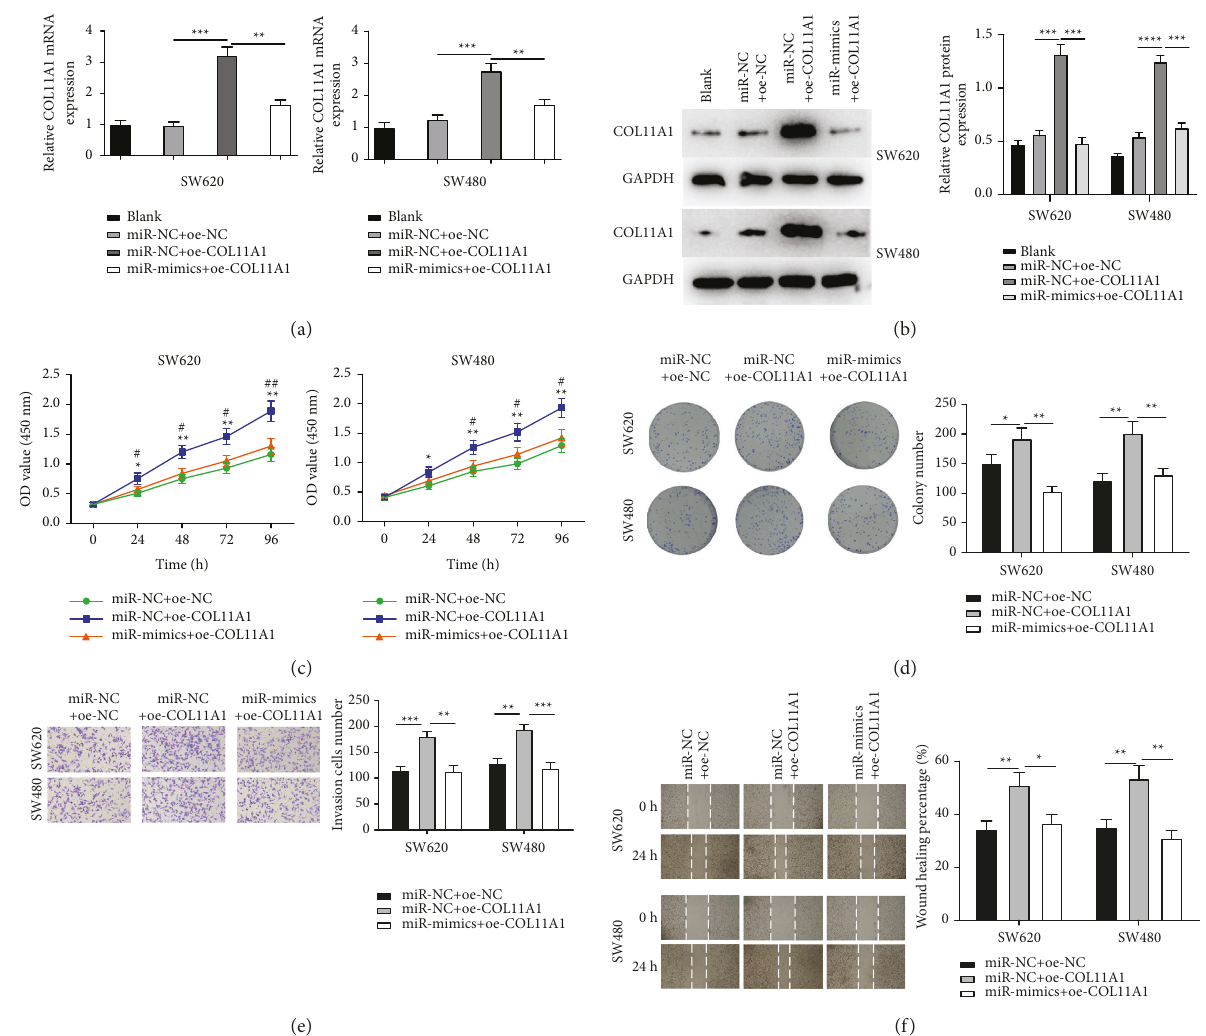
Figure 4: MiR-339-5p suppresses colon carcinoma cell progression through COL11A1 downregulation. (a-b) COL11A1 mRNA and protein levels in colon carcinoma cells SW620 and SW480 in different treatment groups. (c) The viability of SW620 and SW480 cells. (d) The colony formation of SW620 and SW480 cells. (e) The invasive ability of SW620 and SW480 cells (100x). (f) The migratory ability of SW620 and SW480 cells (40x). ∗ p < 0 . 05, ∗∗ p < 0 . 01, ∗∗∗ p < 0 . 001, # p < 0 . 05, ## p < 0 . 01, ### p < 0 . 001, ∗ denotes the comparison between